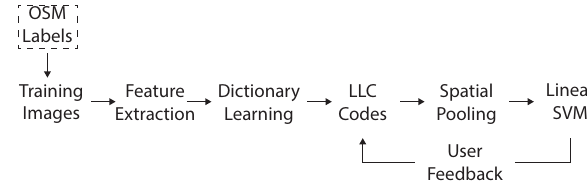
Figure 3: Block diagram of the computational